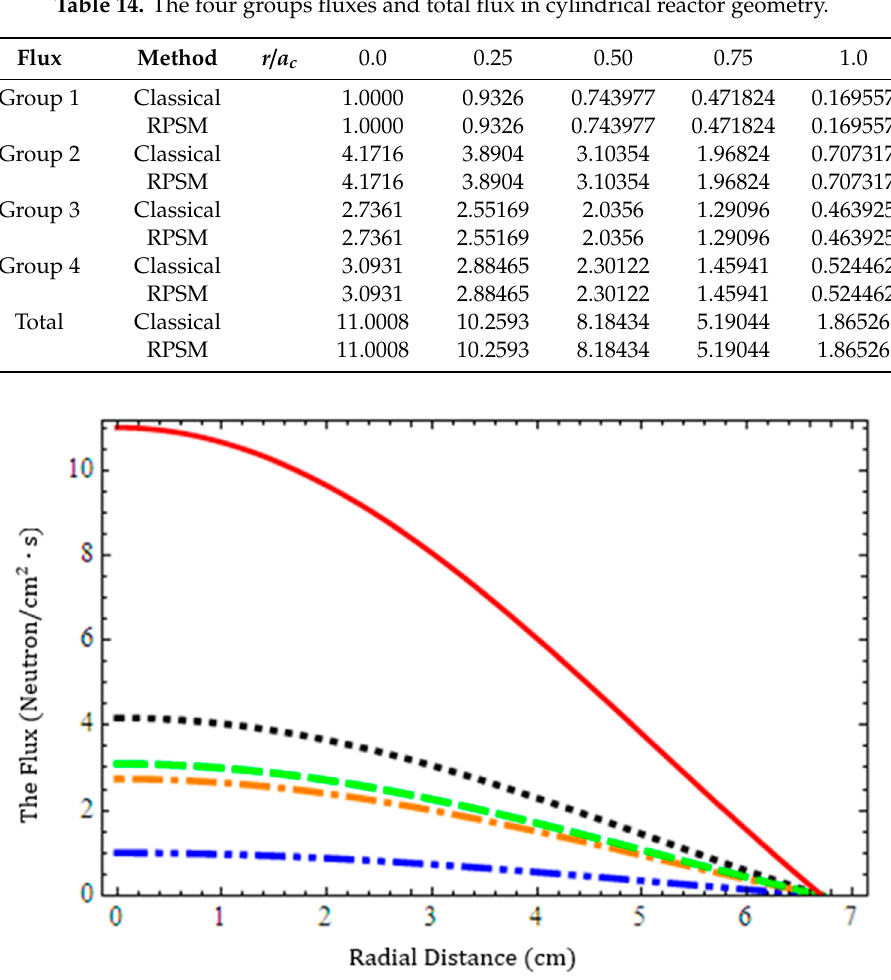
Figure 5. Four energy groups fluxes and total flux for a cylindrical reactor. Dotted-dotted dashed line: ∅ ( r ) , Dotted line: ∅ ( r ) , Dotted dashed line: ∅ ( r ) , Dashed line: ∅ ( r ) , Solid line: Total fluxes. 2 3 1 4